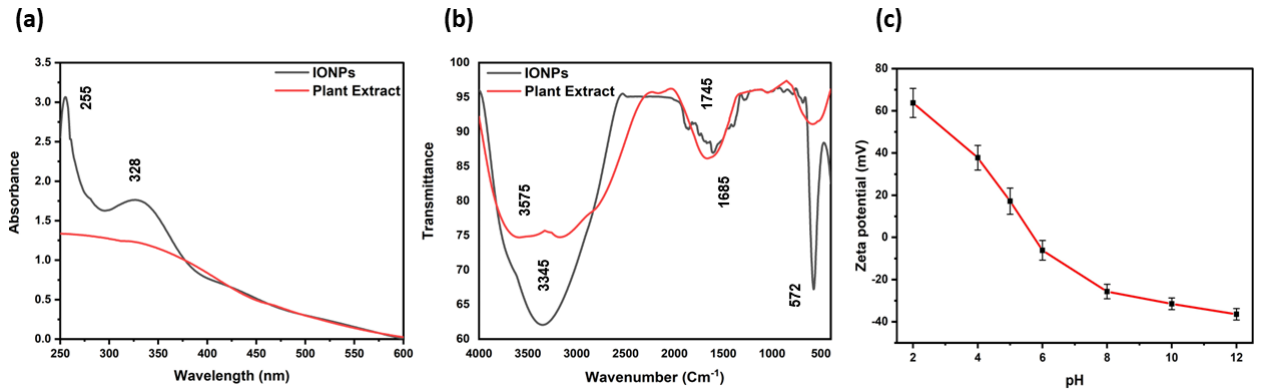
Figure 2. ( a ) UV–Vis spectrum of synthesized IONPs and plant extract, ( b ) FTIR spectra of synthe- sized IONPs and plant extract, and ( c ) Graph illustrating zeta potential vs. pH of biosynthesized